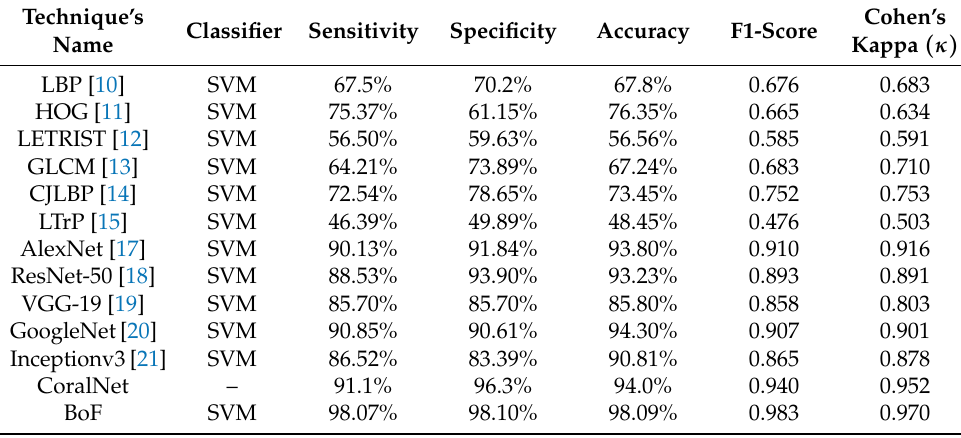
Table 5. Generalized Performance on Moorea Corals